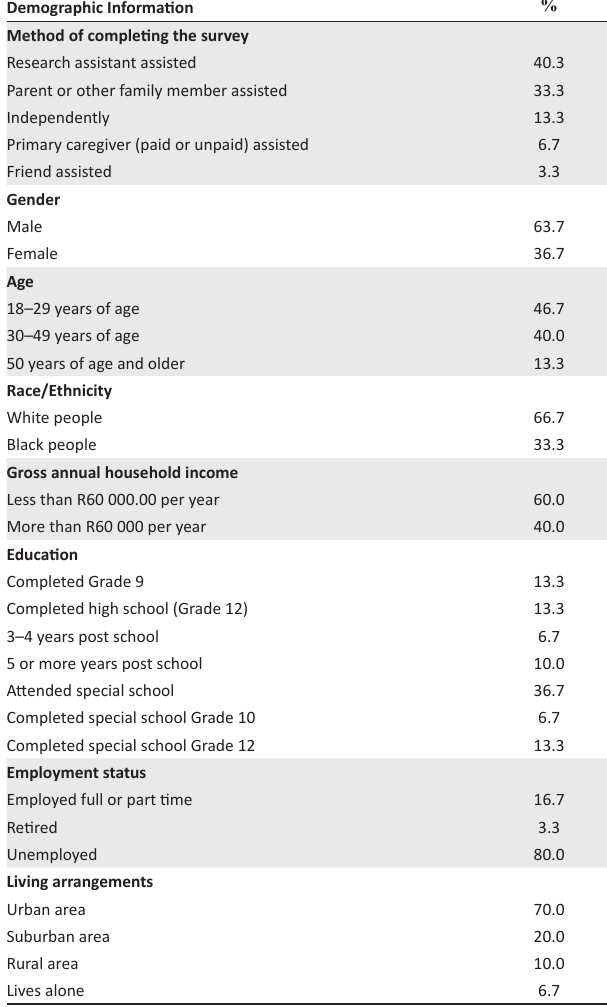
TABLE 1: Participant demographic information ( N =